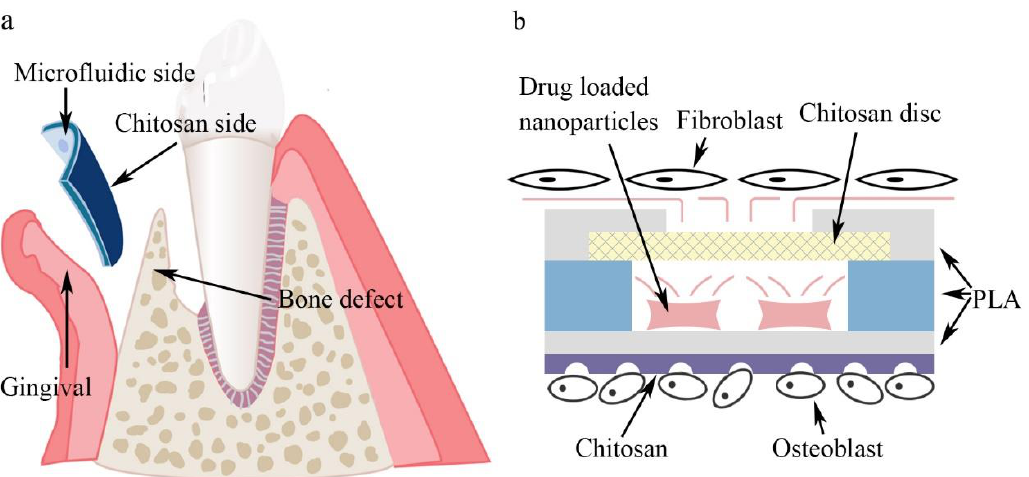
Figure 1. Conceptual illustration of the microfluidic/chitosan device for guided bone regeneration. ( a ) The microfluidic/chitosan device is placed between the gingival region and the bone defect region. ( b ) The working principle of the microfluidic/chitosan device. It can inhibit bacteria proliferation on the microfluidic side and promote bone growth on the chitosan side.